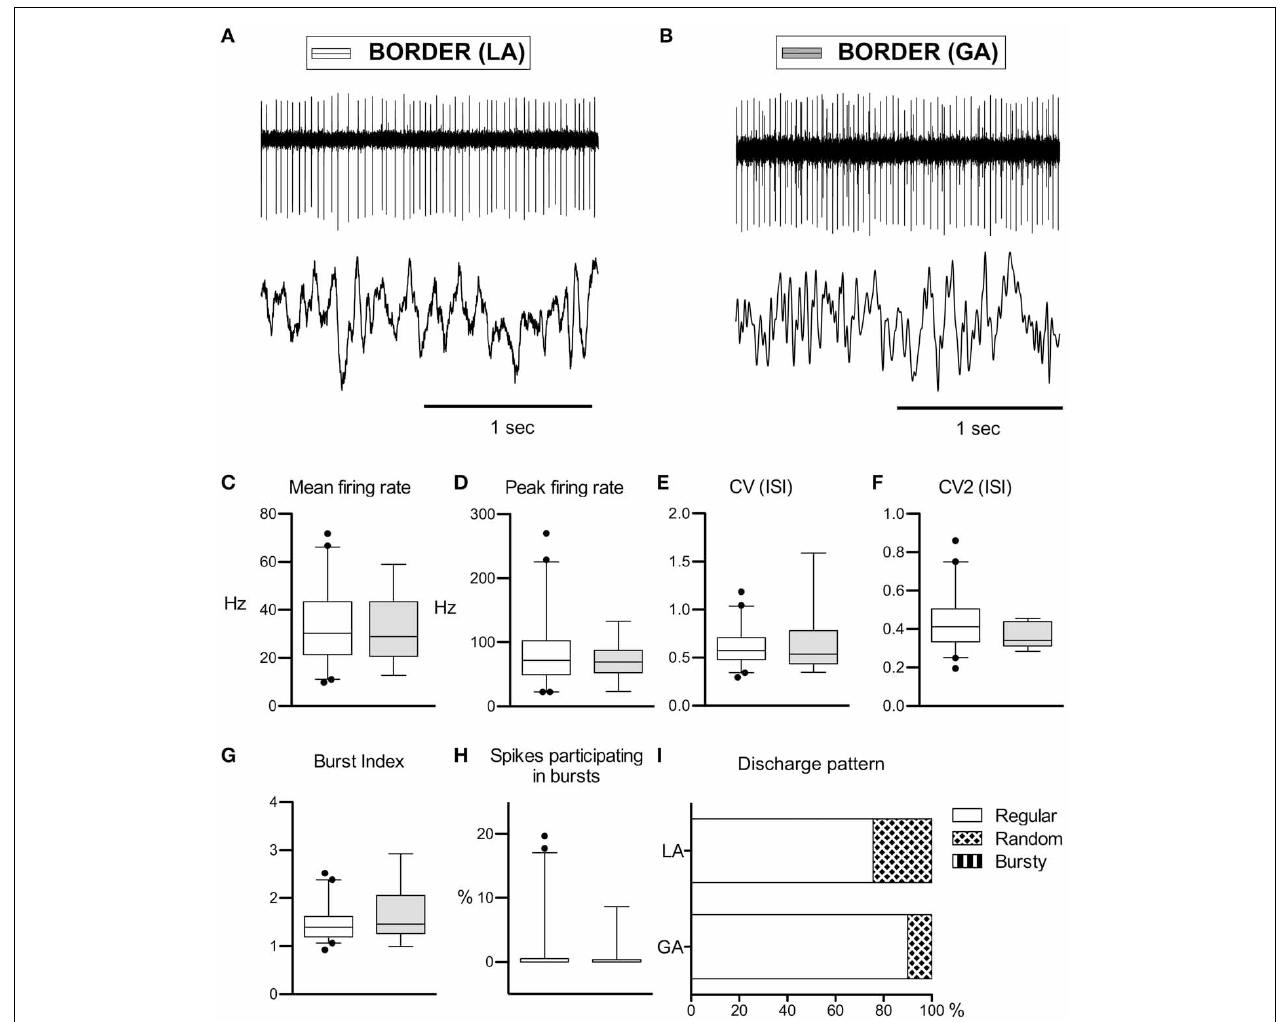
FIGURE 3 | Comparison of discharge rates and patterns of peri-pallidal border cells in patients with CD. (A) Raw trace of a border cell recorded together with a pallidal LFP near the intersection of GPe and GPi in a patient operated under local anaesthesia (case 5). Note the highly regular firing (CV, 0.34) at intermediate frequency (mean firing rate, 26.2Hz). (B) Border cell